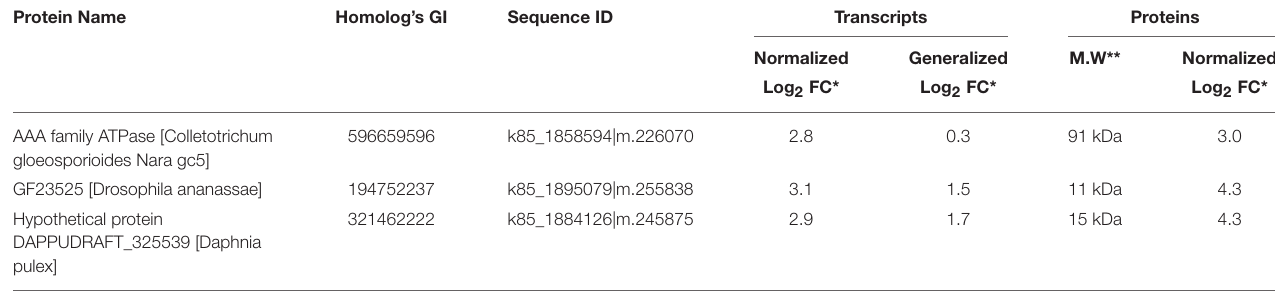
TABLE 5 | Top up differentially integrative transcriptomic and proteomic data between Nauplius VI and Cyprid. Protein Name